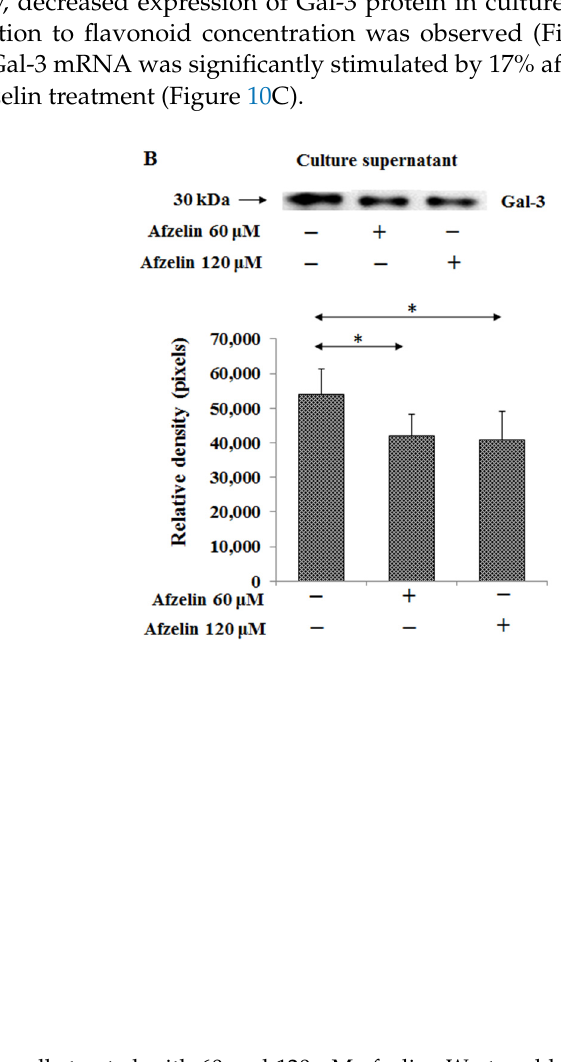
Figure 10. Effect of afzelin on Gal-3 in AGS gastric cancer cells treated with 60 and 120 µ M afzelin. Western blotting was used to determine Gal-3 in cell lysates ( A ) and culture medium ( B ). The β -actin expression served as protein loading control. The bands intensity was quantified by densitometry. Data are presented as the mean ± SD from 3 assays. * p < 0.05; ** p < 0.01; *** p < 0.001. Gal-3 gene expression ( C ) was assessed by RT-PCR. The results are shown as a relative fold change in Gal-3 mRNA expression in comparison to control where expression was set as 1. ± SD are the mean of triplicate cultures. * p < 0.05; ** p < 0.01.